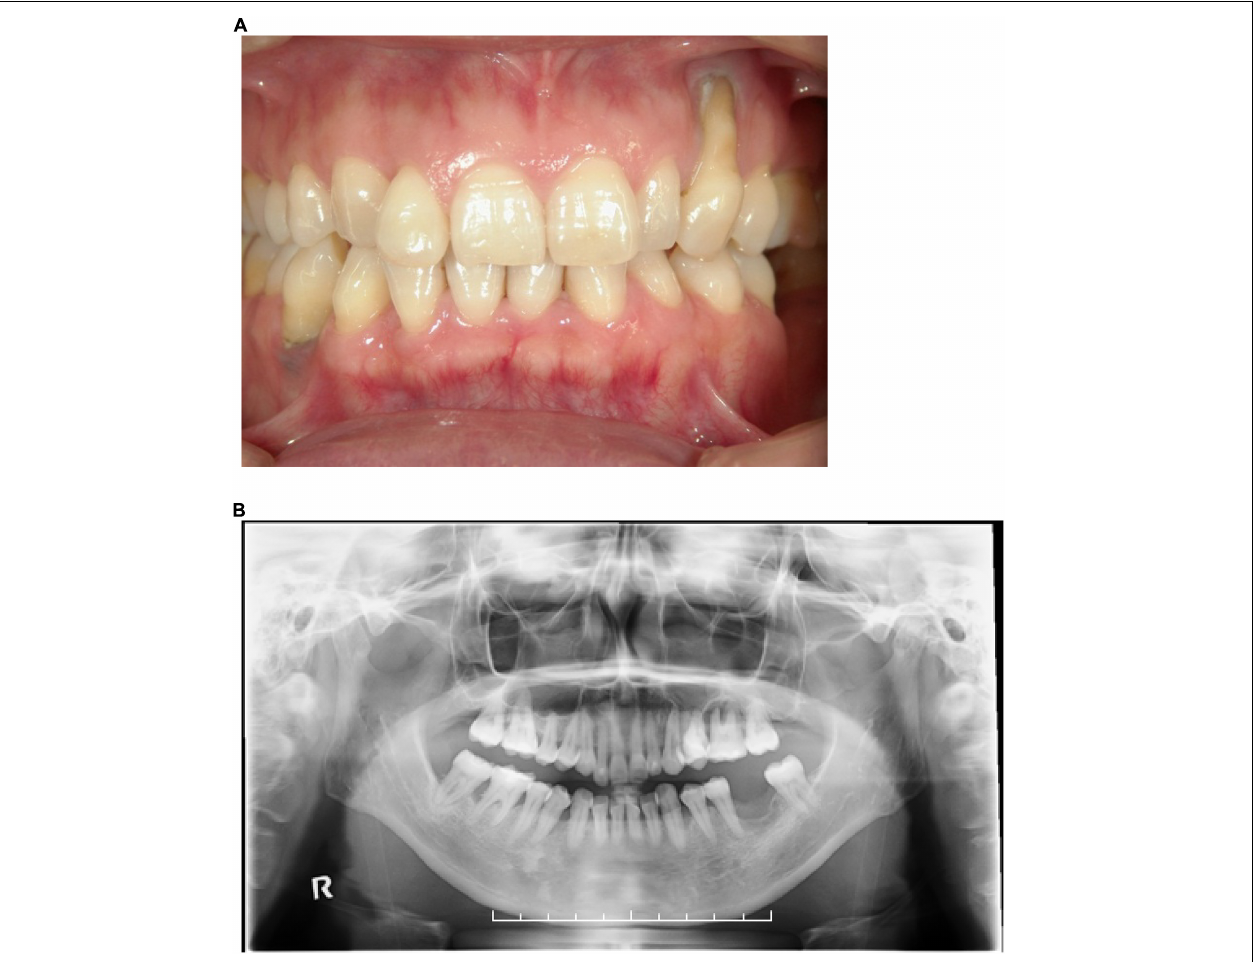
FIGURE 1 | (A) Front view of the dentition of a patient with LDS and aggressive periodontitis. (B) Orthopantomograph of the patient. Note the presence of localized vertical bone loss around molars.